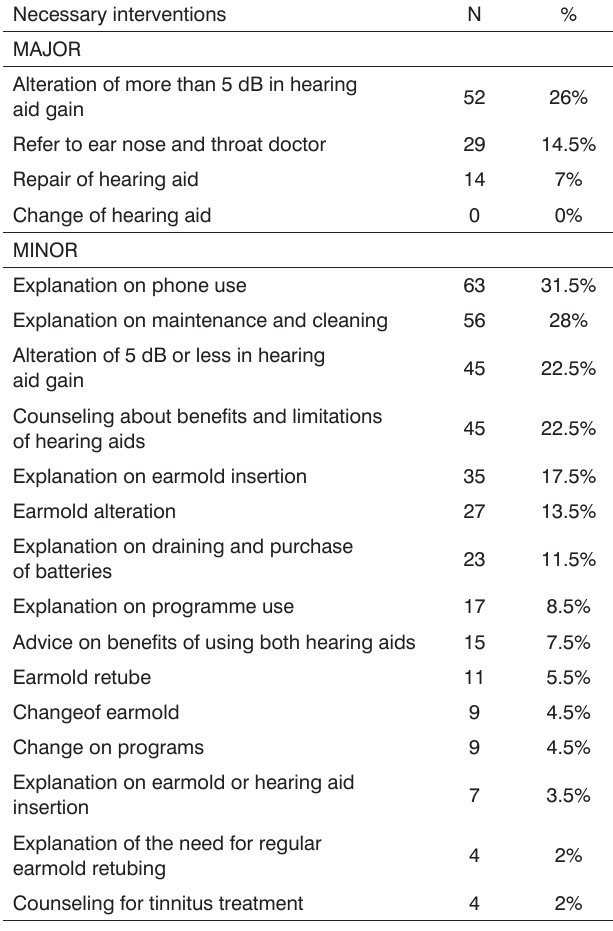
Table 3. Frequency and percentage frequency